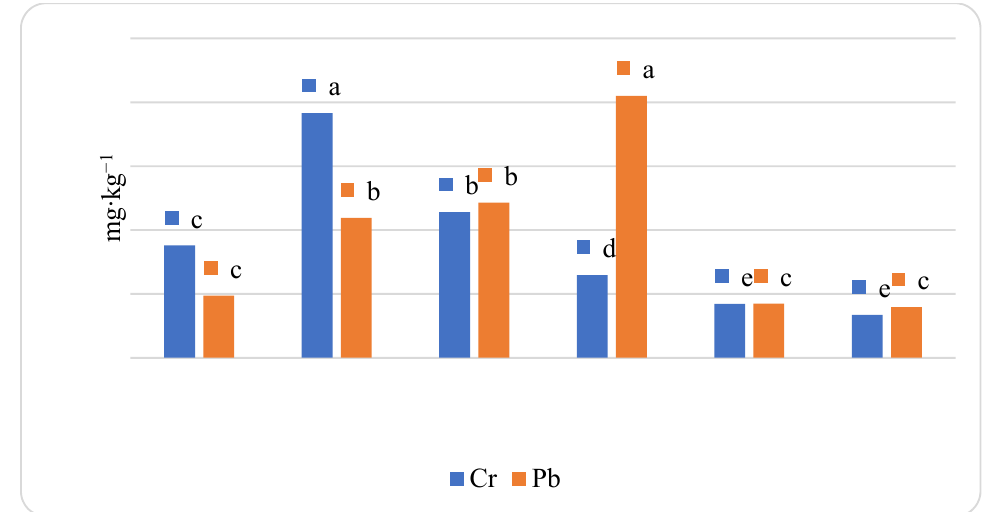
Figure 4. Heavy metal total contents (Cr, Pb) in analyzed vermicomposts and composts (the same lowercase letters indicate homogeneous groups of VCs and Cs).